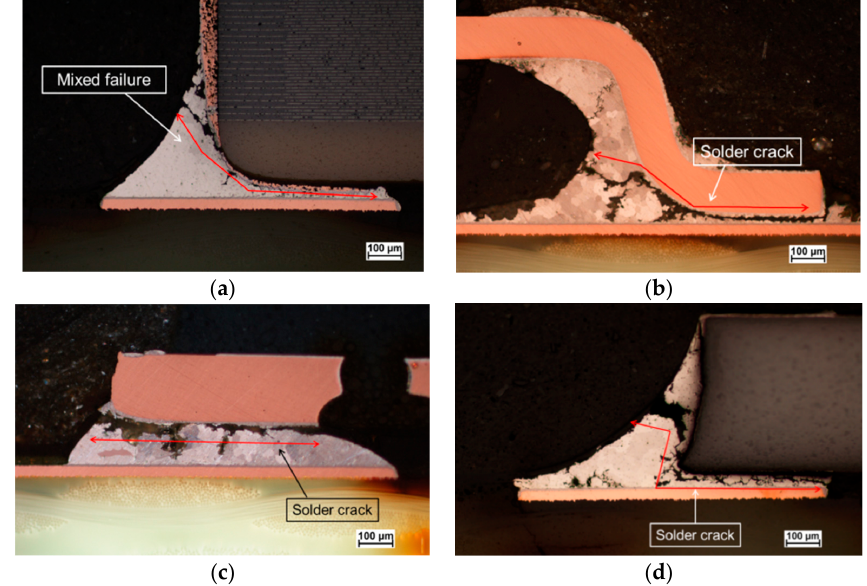
Figure 9. Images showing the failed solder joints of different components: ( a ) a mixed mechanism of failure of a ceramic capacitor, and cracks in the solder joints of ( b ) TSSOP, ( c ) MLF28, and ( d ) CR1206.